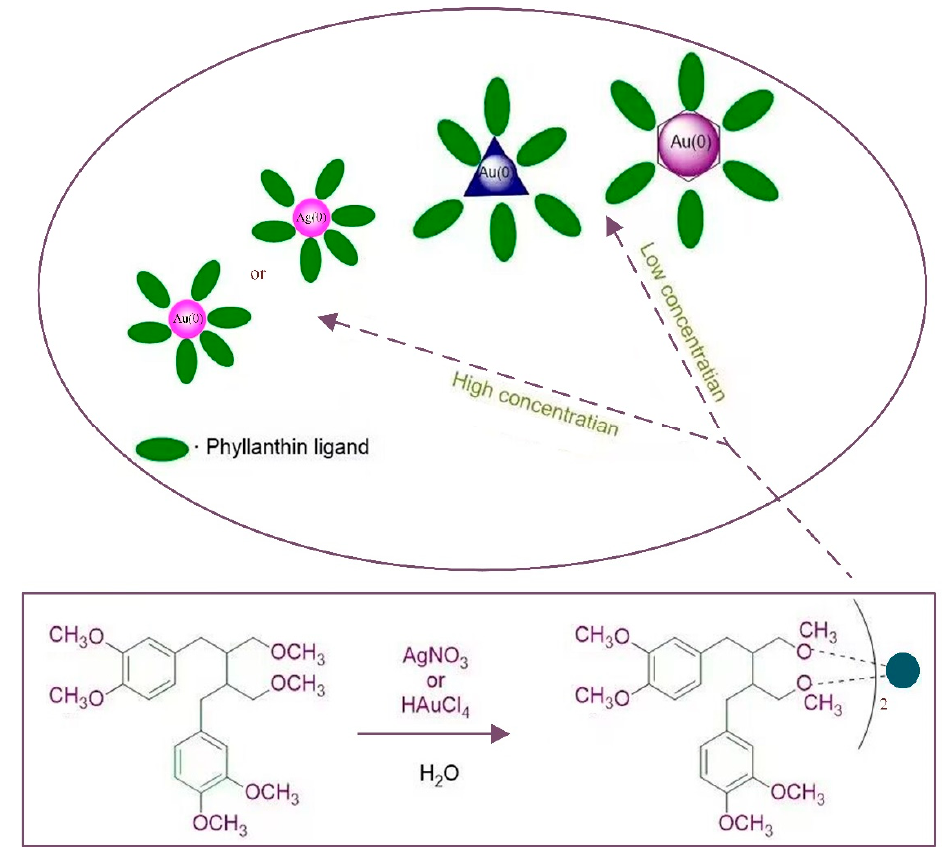
Figure 8. Schematic diagram of the formation of phyllanthin stabilized Au/Ag NPs. Microbes-mediated synthesis: Microbes biosynthesize NPs by grabbing target ions from their surroundings, which are subsequently transformed into elemental metal atoms by enzymes produced by cellular activity. Depending on the site of NP creation, microbial-mediated NP synthesis occurs intracellularly or extracellularly, and the synthesis method is depicted in Figure 9. Metal ions are captured on the cell surface and reduced in the presence of enzymes in extracellular NP production, whereas metal ions are carried inside the microbial cells in the presence of enzymes to create NPs in intracellular NP synthesis [55]. Gerick and Pinches [56] demonstrated the intracellular synthesis of gold nanoparticles of different morphologies and sizes in two fungal cultures (V. luteoalbum and isolate 6–3). They found that by controlling parameters, such as pH, temperature, gold concentration, and AuCl 4 exposure time, the rate of particle formation, as well as the size of the nanoparticles, could be controlled to some extent. Also, the extracellular bio- synthesis of Ag NPs using the fungi Aspergillus fumigatus and Fusarium